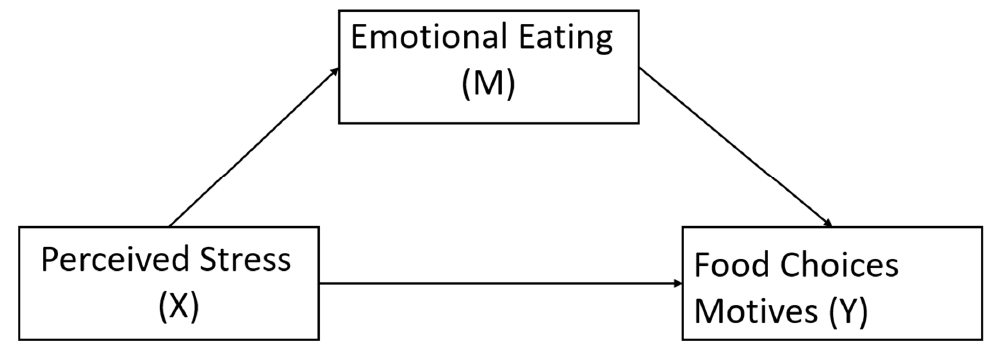
Figure 1. Proposed mediation model of perceived stress on food choice motives.